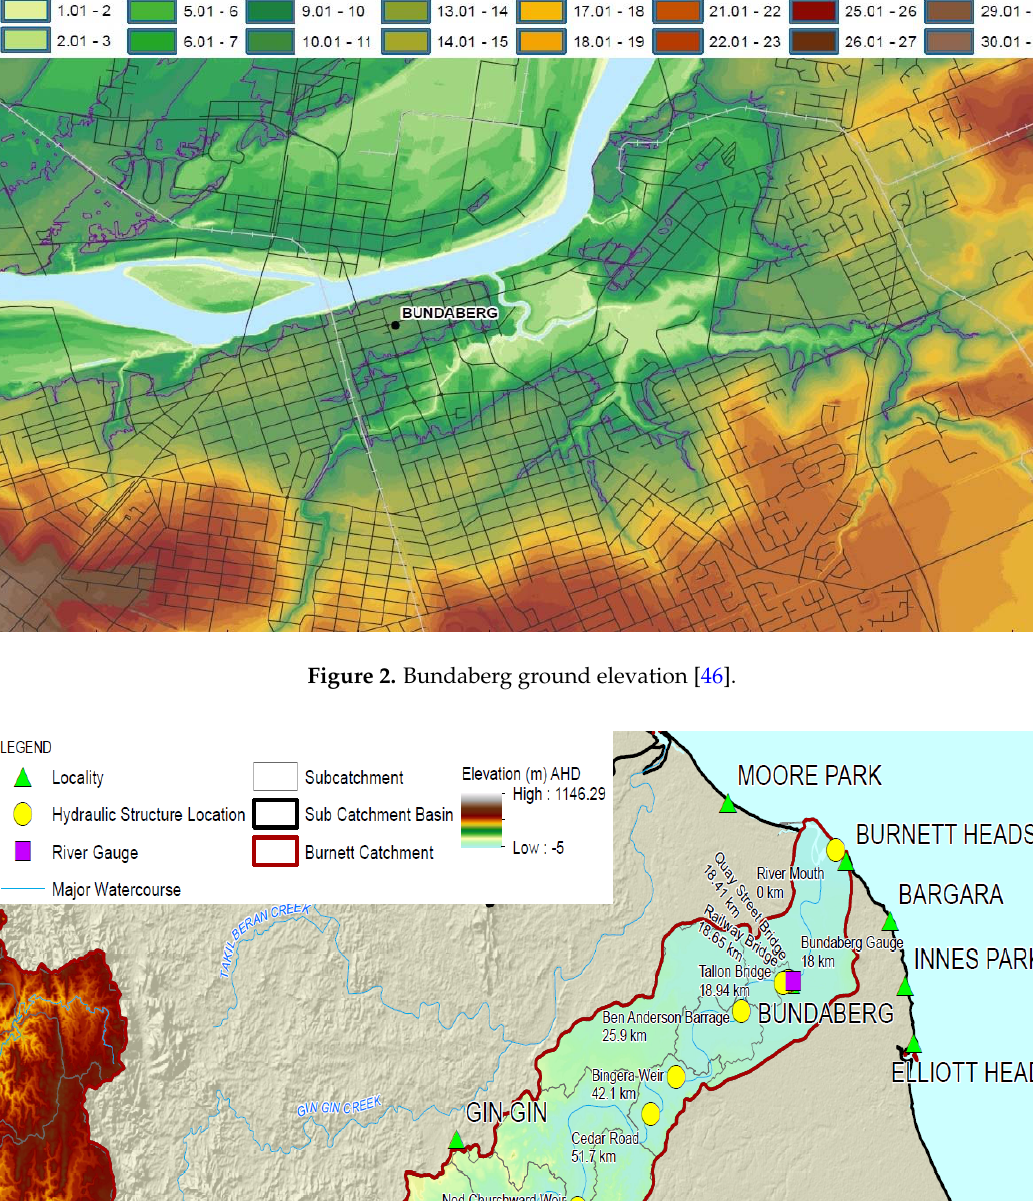
Figure 1. Map of Bundaberg Regional Council [45].